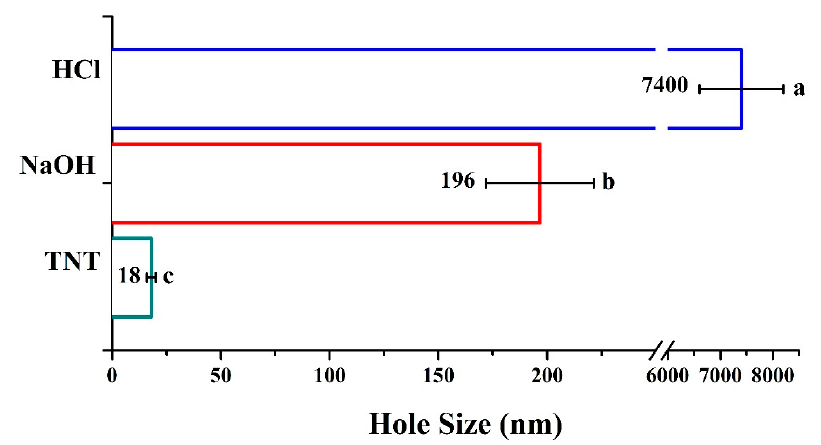
Figure 3. The holes size of the titanium sheet after different surface treatments. Means with different letters were significantly different ( p < 0.05, mean ± SD, n = 10). Table 2. Surface element analysis of the titanium sheet with different surface treatments and samples after LAB treatments by EDX.